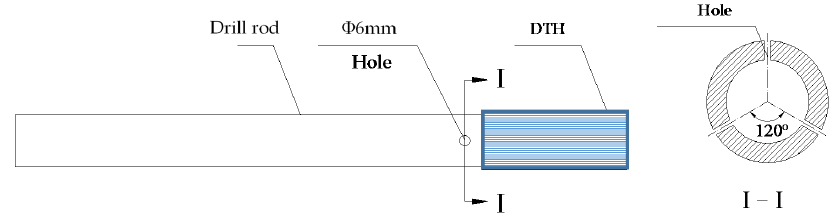
Figure 4. Arrangement parameters of holes in the body of the drill rod to prevent sticking. DTH: down-the-hole drill.